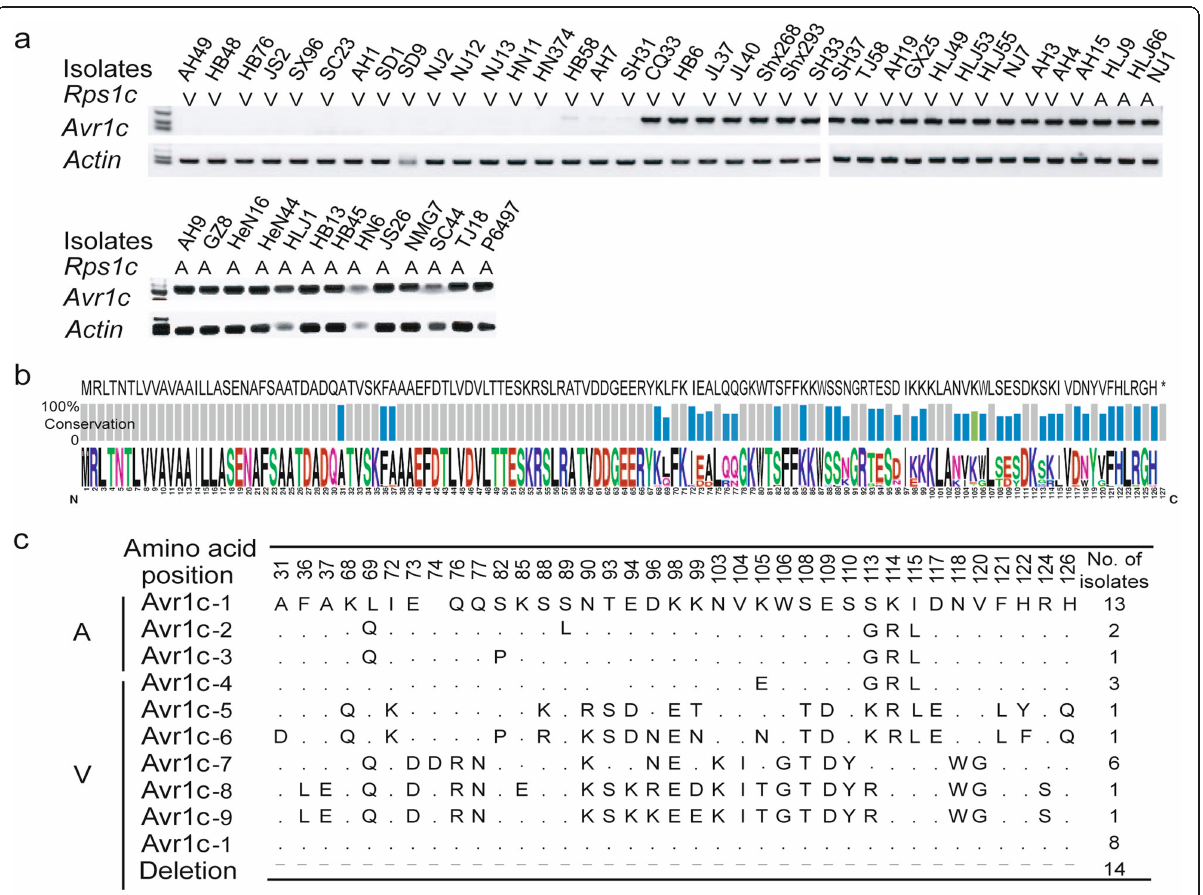
Fig. 2 Polymorphism analysis of Avr1c. a PCR amplification of Avr1c . A, the isolates were avirulent on Rps1c ; V, virulent on Rps1c . P6497 was used as the control. b Amino-acid sequence of Avr1c-1. Conserved sites (grey), variation sites (blue), and key recognition site (green). The consensus sequence and sequence diversity are depicted as sequence logos. c Amino-acid sequences encoded by Avr1c variants. Identities are indicated by dots and substitutions by the substituted residue. *, stop codon